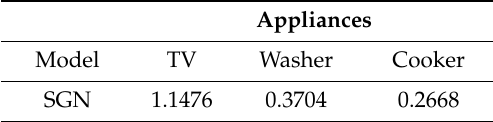
Table 7. Summary of regression performance (mean absolute error (MAE)